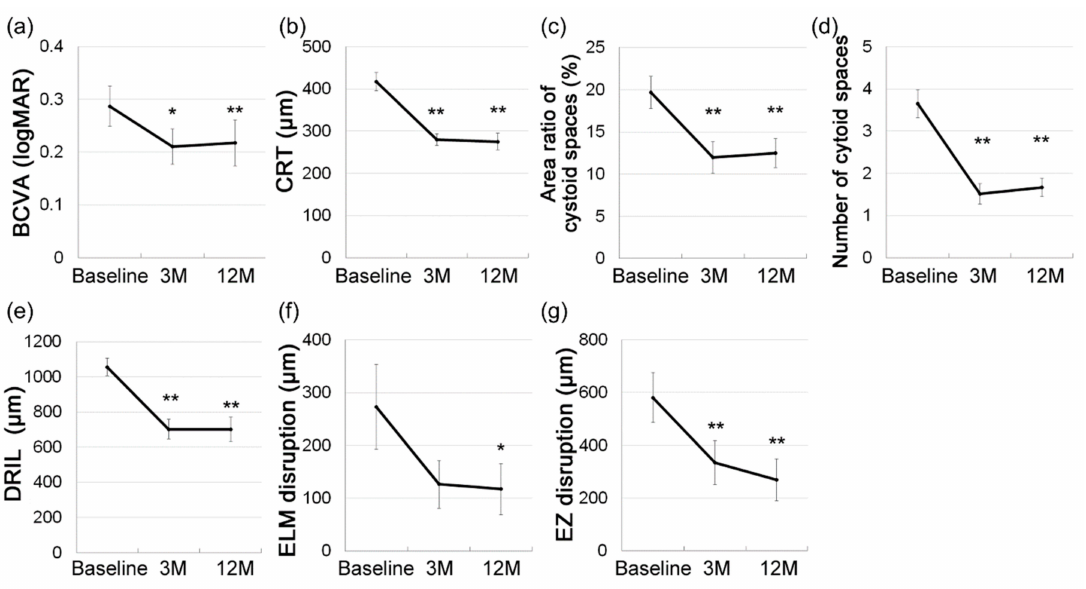
Figure 1. Treatment outcome of intravitreal ranibizumab monotherapy for diabetic macular edema. Repeated measure ANOVA was performed to compare the values of best-corrected visual acuity (BCVA, a ), central retinal thickness (CRT, b ), area ratio ( c ), number ( d ) of intraretinal cystoid spaces, extents of disorganization of the retinal inner layers (DRIL, e ), and external limiting membrane (ELM, f ) and ellipsoid zone (EZ, g ) disruptions at 3 and 12 months with those at baseline. Values significantly decreased 3 and 12 months after initial treatment compared with baseline, except for ELM disruption, which showed a decrease at 3 months. Data are shown as mean ± standard error. * p < 0.05, ** p <